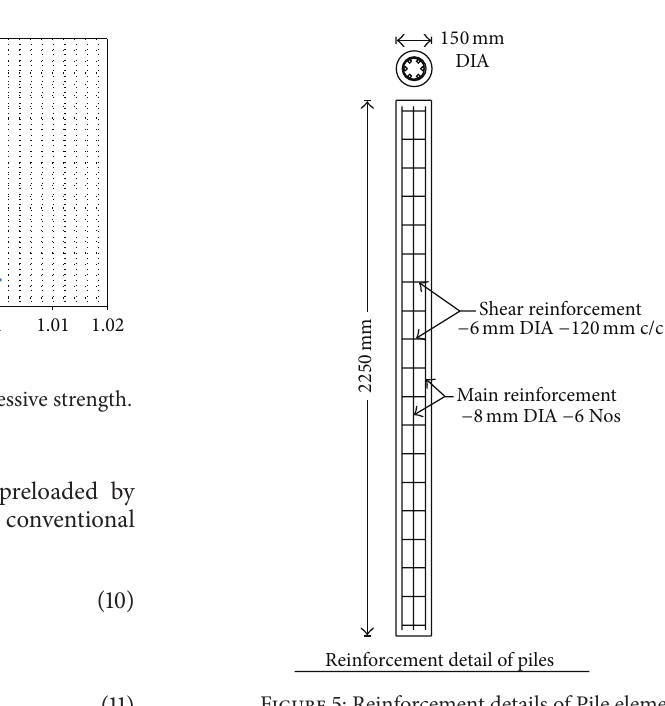
Figure 5: Reinforcement details of Pile